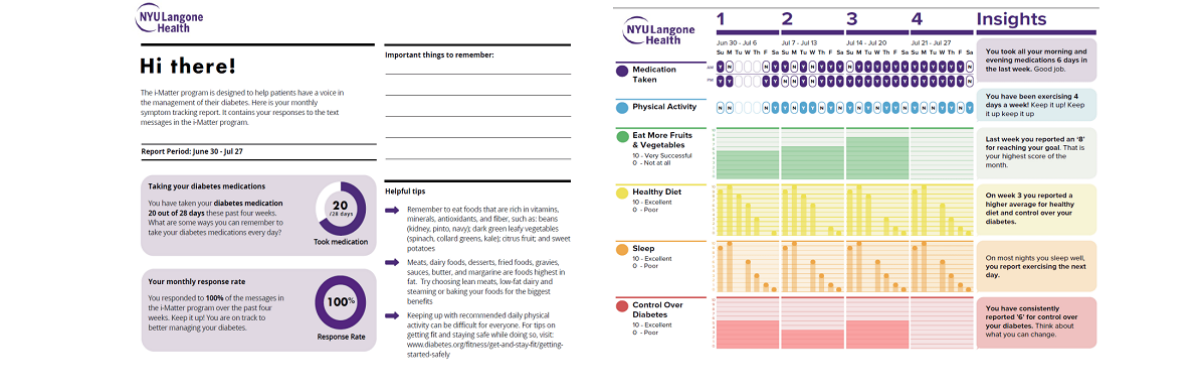
Figure 2. Example of a final personalized report after two rounds of user testing.